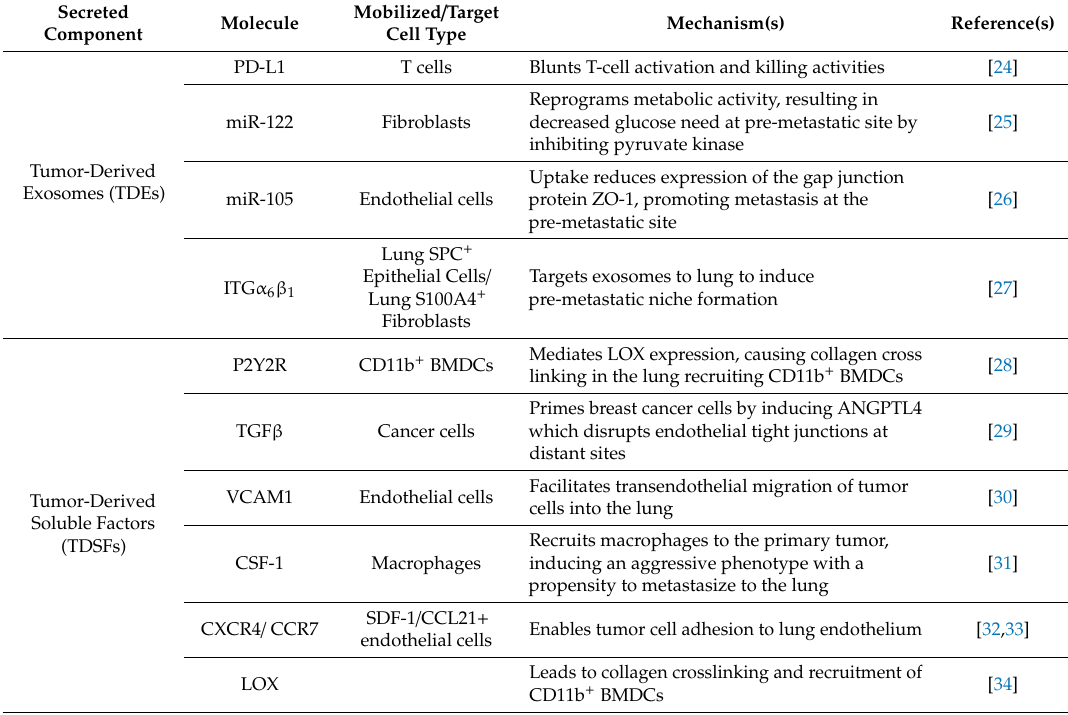
Table 1. Molecular and cellular components secreted by breast cancer primary tumors that are associated with the promotion of lung